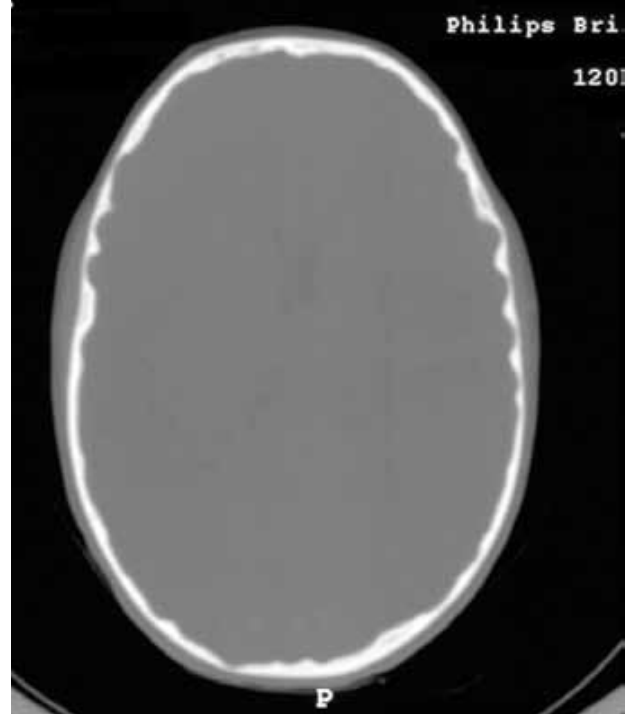
Fig. 2. Axial CT of brain bony windows, demonstrating the convolutional markings of the inner table of the skull that conform to the cerebral surface of the growing brain associated with fusion of the coronal and lamdoid